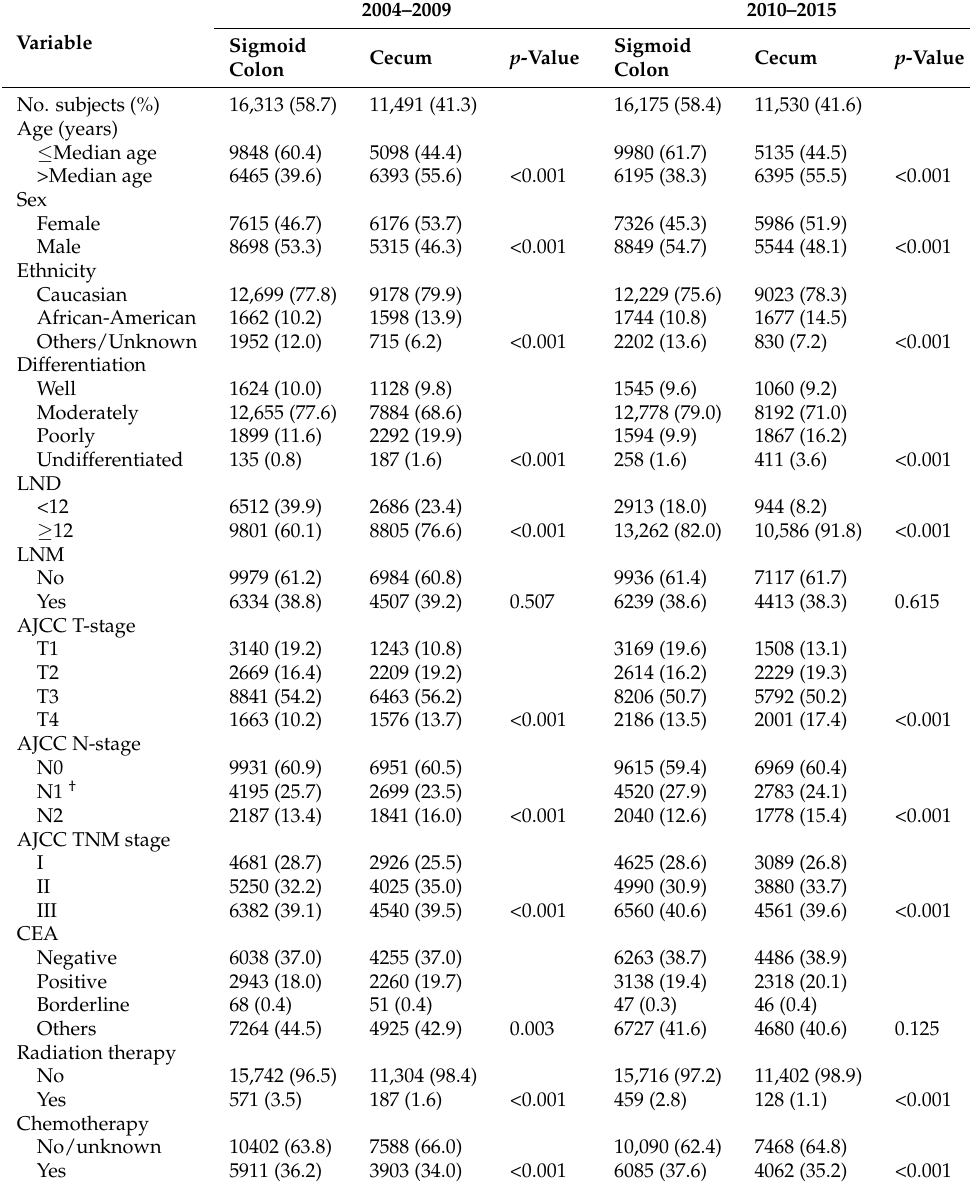
Table 2. Comparison of clinicopathological data of patients with sigmoid colon cancer versus cecum cancer in the SEER